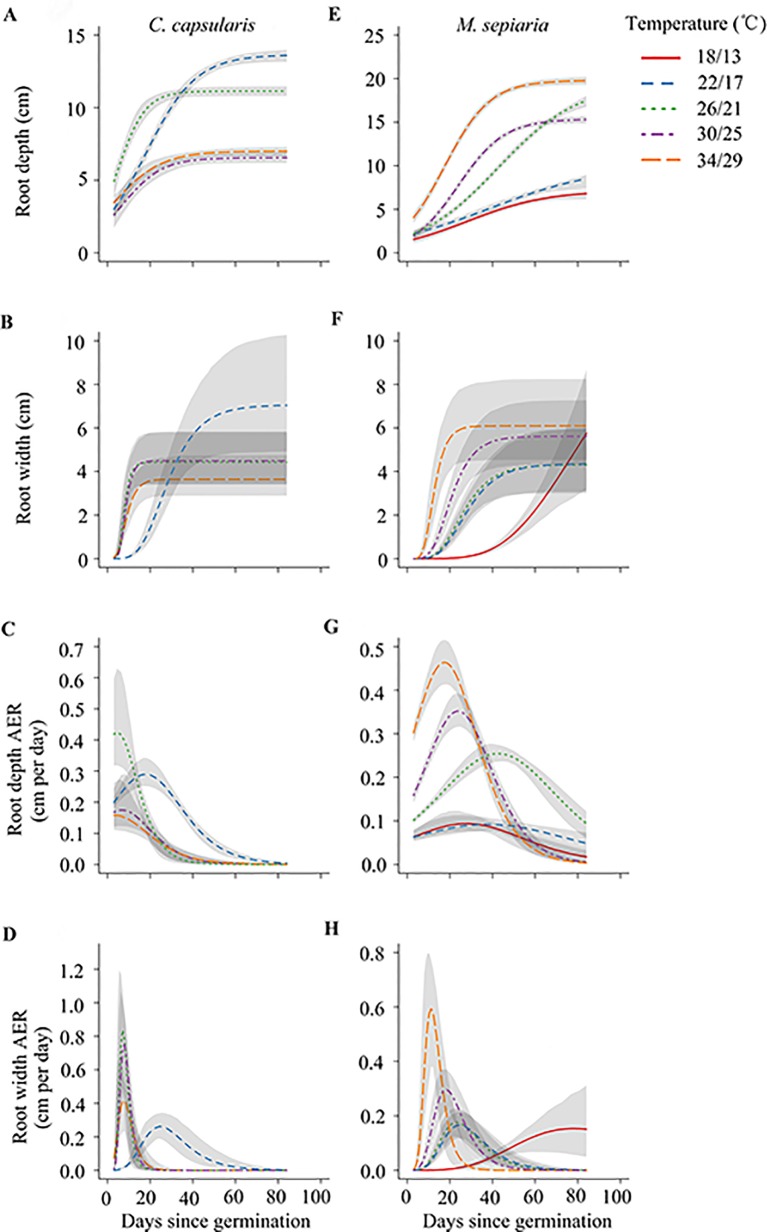
Temperature effects on the dynamics of two root size-related metrics and their absolute expansion rate (AER) of two species under different temperature treatments. Graphs show predicted values with 95% confidence intervals (gray curves) for (A–D)
C. capsularis, (E–H)
M. sepiaria.